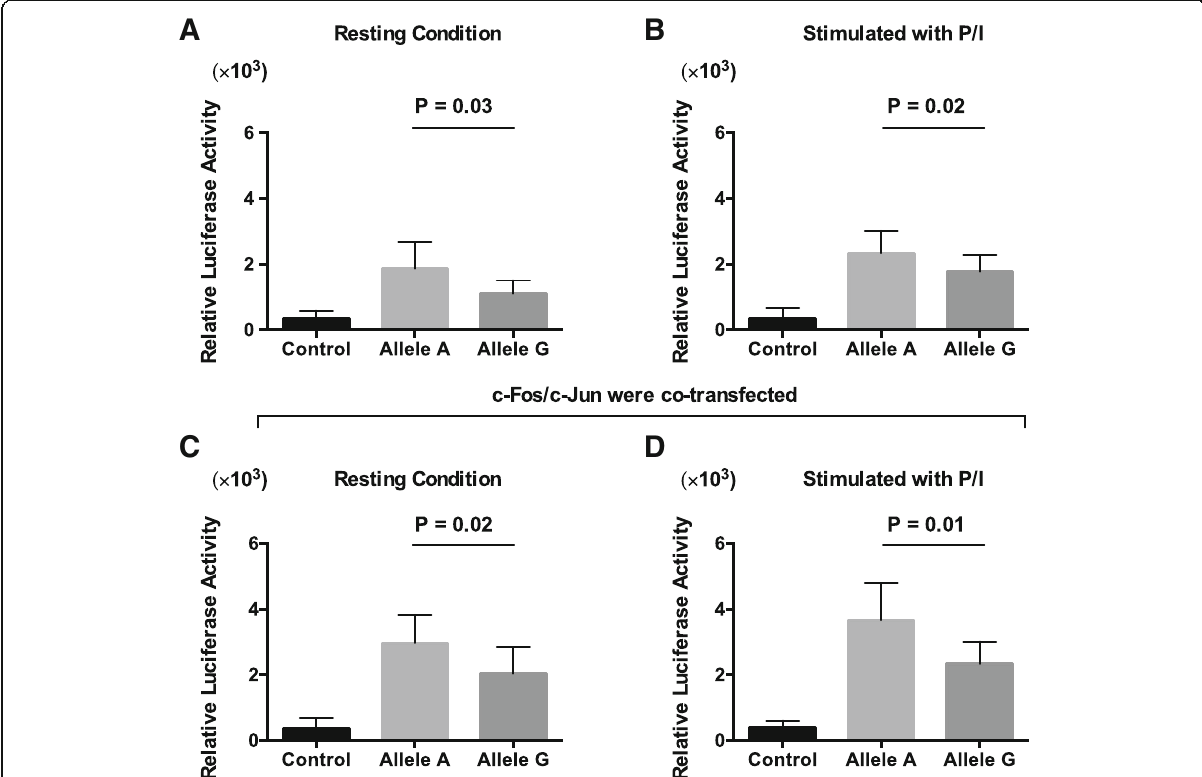
Fig. 4 The regulatory element containing the rs12905203 variant demonstrates enhancer activity. a and b Sequences carrying risk (G) and non- risk ( a ) variants were cloned upstream of a minimal thymidine kinase promoter luciferase construct to measure luciferase activation following transient transfection and stimulation with PMA/Ionomycin. c and d The luciferase activity assay vectors were co-transfected with constructs expressing AP-1 transcription factors. Seventy-two hours post-transfection, luciferase activity for risk and non-risk variants was measured and compared to the control. The statistical differences between risk and non-risk alleles of the variant were calculated using Student ’ s